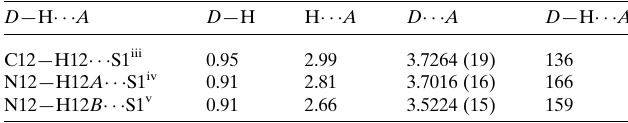
Table 2 Hydrogen-bond geometry (A˚ , (cid:5)